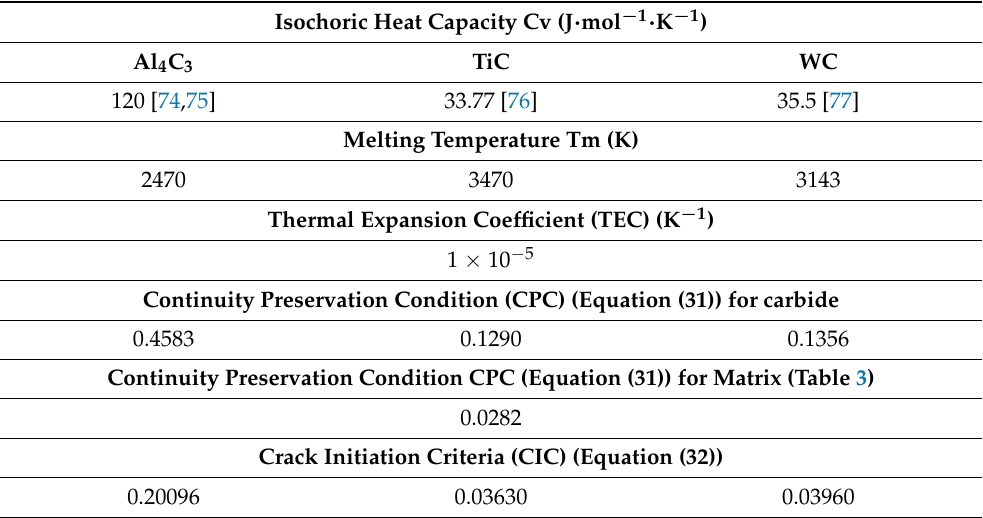
Table 7. Thermodynamic properties of phases, CPC and CIC